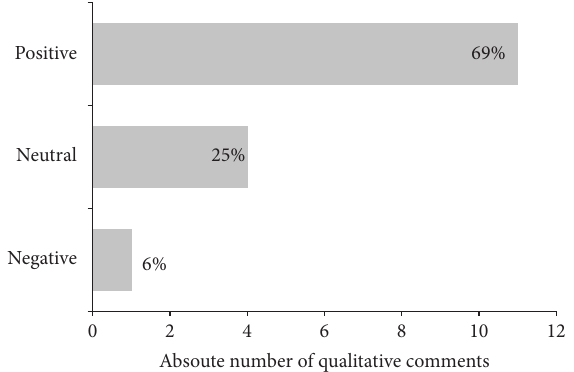
Figure 4: Qualitative rating of allied health personnel comments with respect to postextubation prone positioning abstracted from healthcare